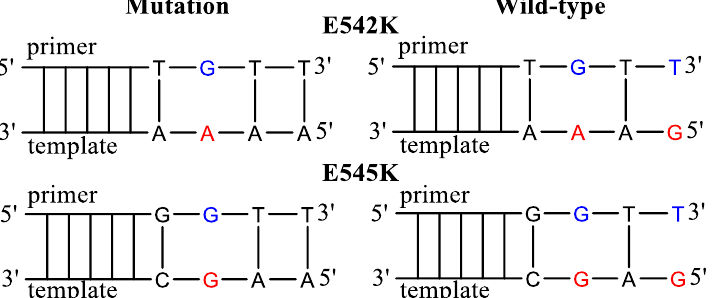
Table 1. AS-PCR Primers for PIK3CA E542K and E545K mutation detection.